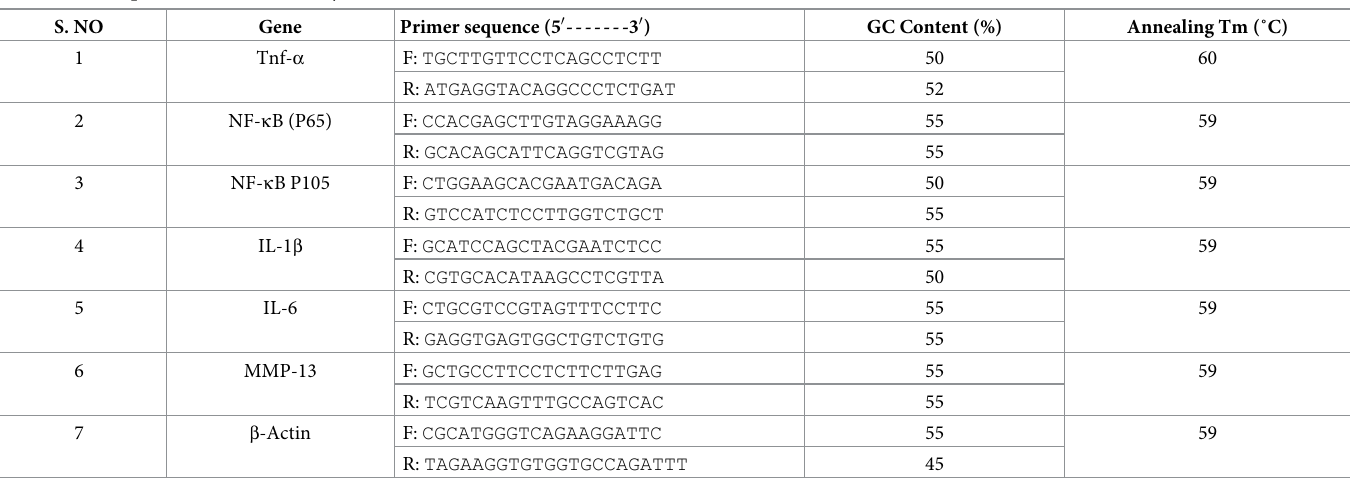
Table 1. List of primers used in the